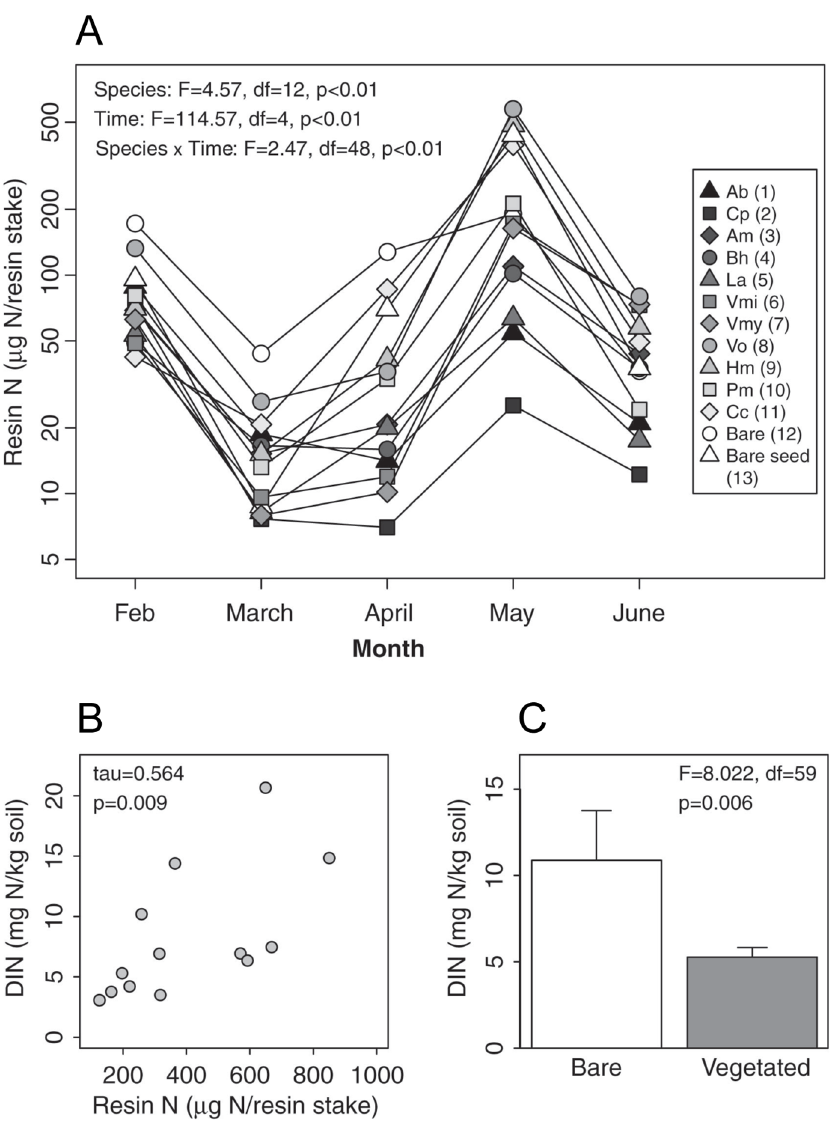
Figure 2. Resin available N in soil during growing season. A Point measures over time in monoculture and bare plots. Species are listed in order of monoculture aboveground biomass and this rank is noted in parenthses (1=greatest biomass, 12=lowest biomass) and denoted with increasing grayscale values for symbols indicating greater plant biomass. B Relationship between cumulative resin-available N (summed over time) and final DIN levels (R*) in monoculture and bare plots. C Final DIN in bare and planted plots. Data were log transformed to account for non- normality prior to analyses, and bars show backtransformed coefficients ( 6 1SE) reflecting bare and planted DIN means. Species abbreviations: Amsinkia menziesii (Am), Avena barbata (Ab), Bromus hordeaceous (Bh), Calandrinia ciliate (Cc), Clarkia purpurea (Cp), Hordeum murinum (Hm), Lamarkia aurea (La), Polypogon monspielensis (Pm), Vulpia microstachys (Vmi), Vulpia myorus (Vmy) and Vulpia octoflora (Vo). Bare seeded plots received seed addition, but did not germinate (see